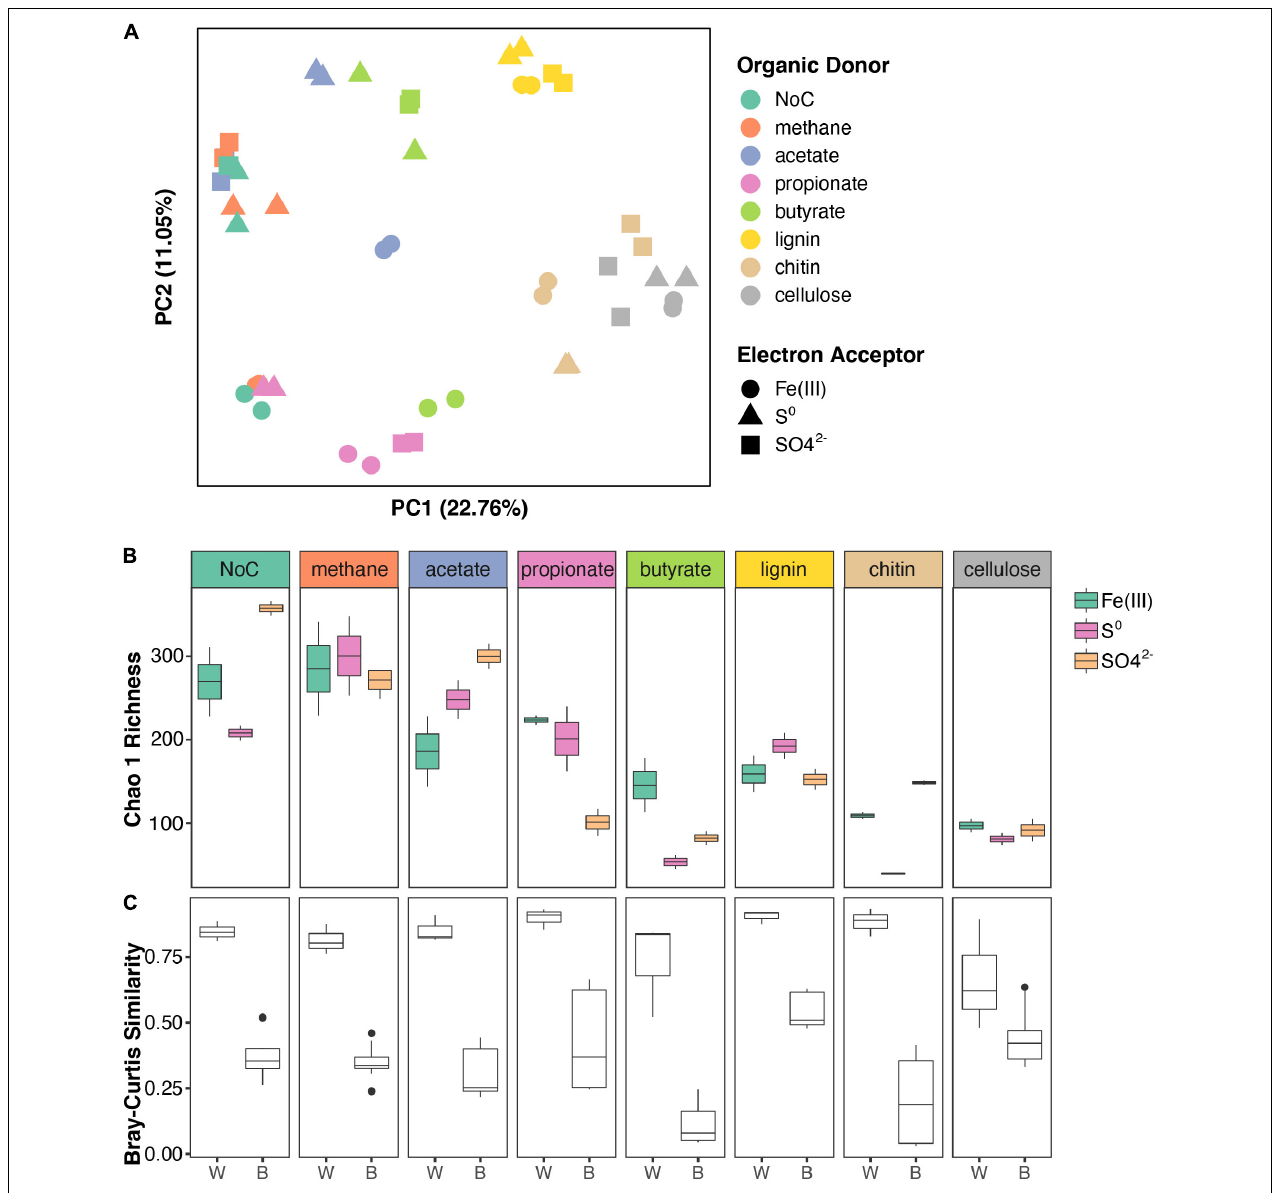
FIGURE 4 | Structure and diversity of enrichment cultures grown on different organic electron donors and terminal electron acceptors. (A) PCoA of enrichment cultures based on Bray–Curtis distances. Samples are color coded based on the organic electron donor (i.e., carbon source) supplied and shapes indicate the terminal electron acceptor. (B) Boxplots of Chao 1 richness in enrichment cultures. The boxplots are plotted for each organic electron donor and are color-coded by electron acceptor. (C) Boxplots showing Bray–Curtis similarity values within (W) enrichment cultures (same organic electron donor and terminal electron acceptor) and between (B) enrichment cultures (same organic electron donor and different terminal electron